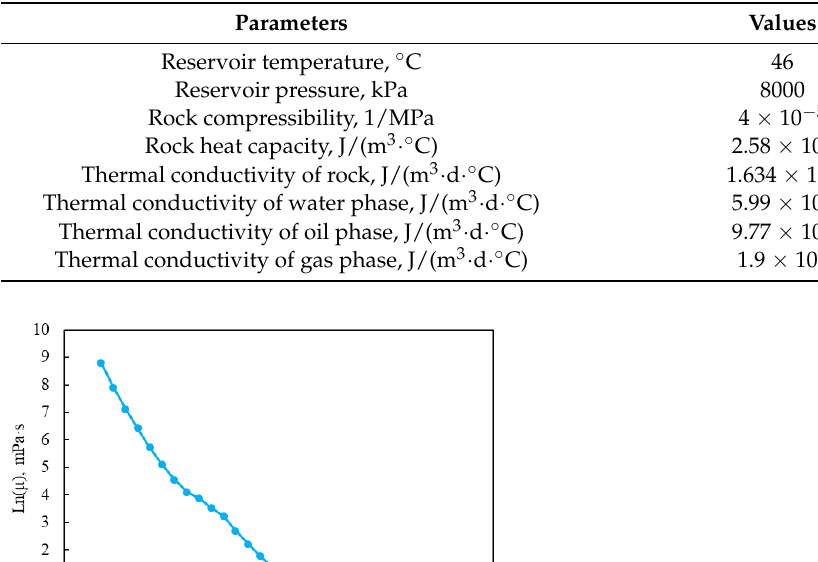
Table 4. The reservoir fluid and rock properties used in the model.